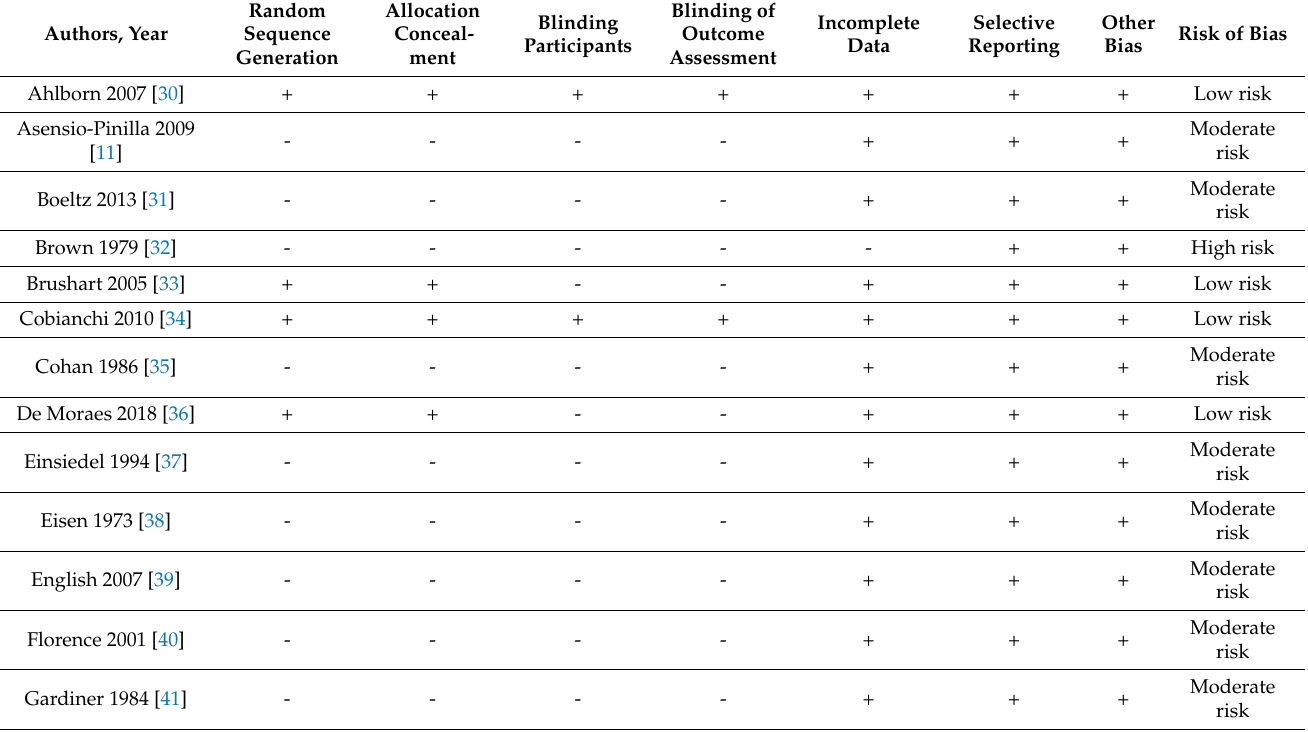
Table 4. Risk of bias summary for each included